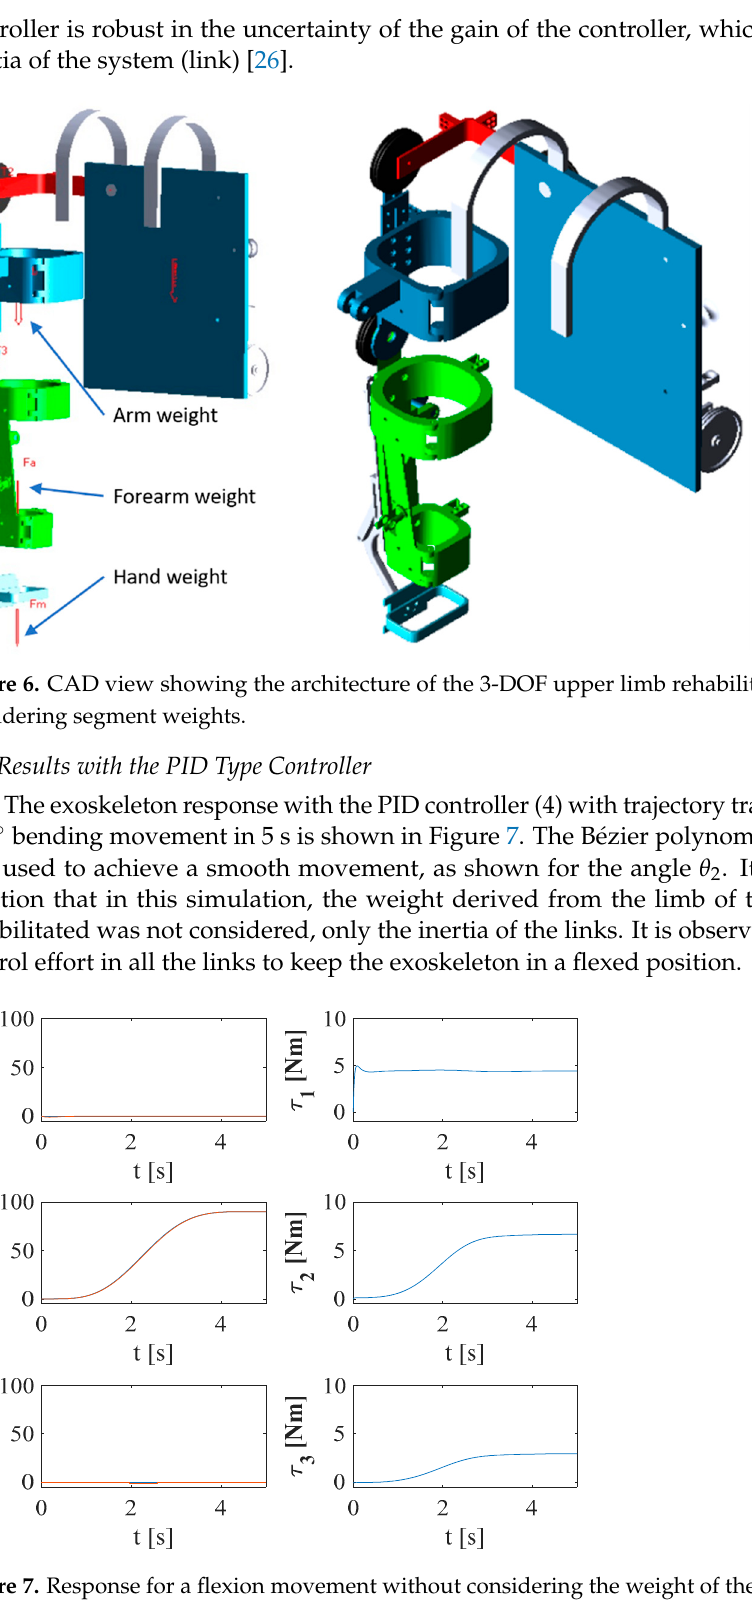
Figure 7. Response for a flexion movement without considering the weight of the patient’s arm.